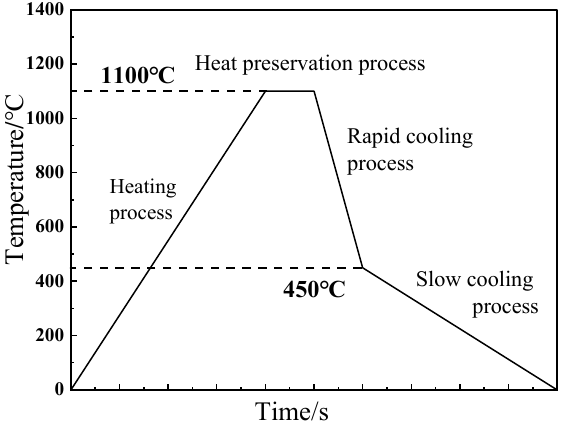
Figure 14. Heat treatment process.